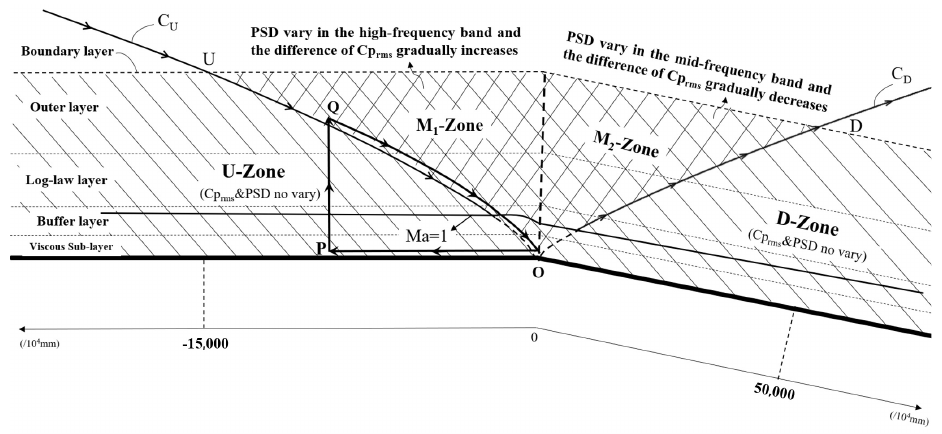
Figure 13. The pressure fluctuation in the U-zone, M-zone and D-zone